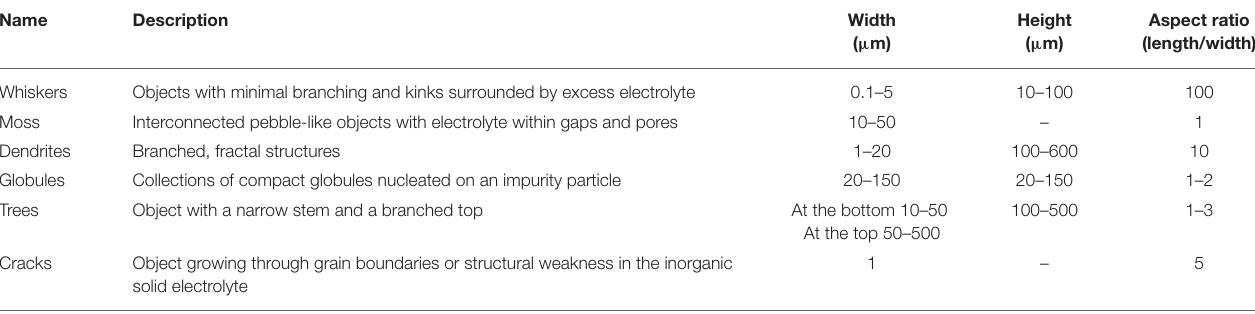
TABLE 2 | Name, description, characteristic width, and aspect ratio of electrodeposited lithium morphologies.